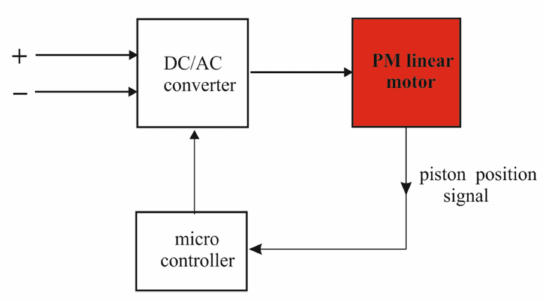
Figure 6. Block diagram of the motor drive operating with a position feedback control